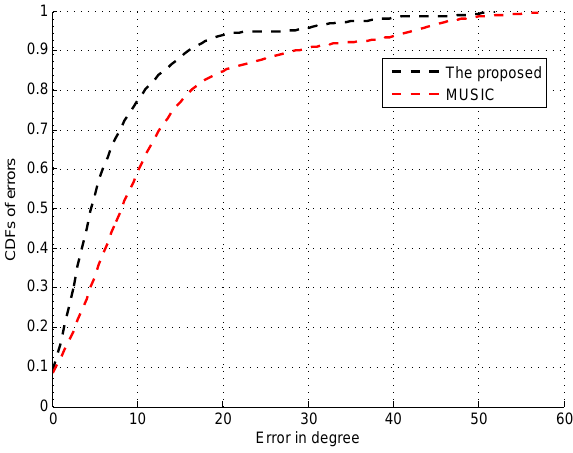
Figure 14. CDFs of errors of AOA